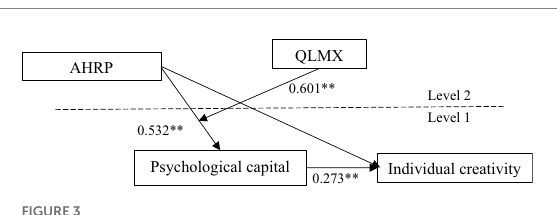
FIGURE 3 Path coefficient diagram of model. * p < 0.05, ** p <